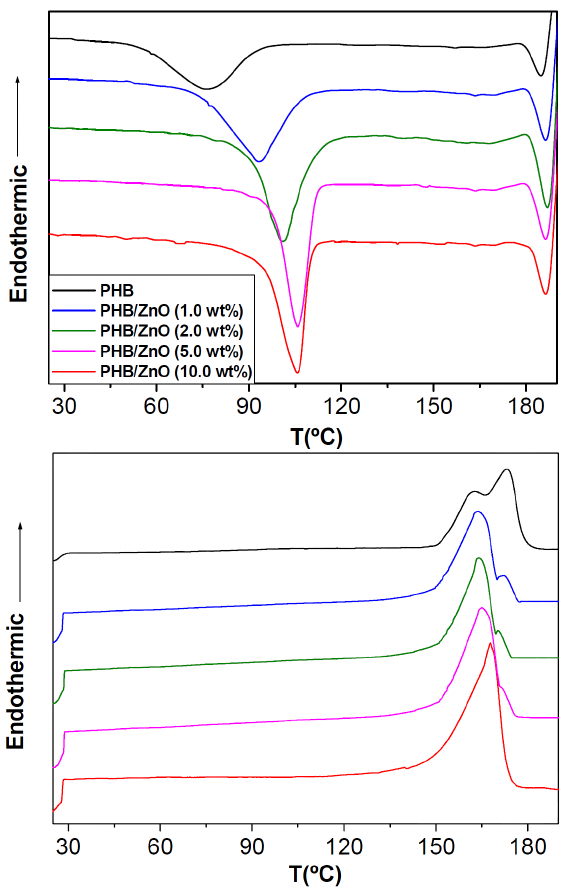
Figure 5. Non-isothermal DSC cooling ( top ) and second heating ( bottom ) scans of PHB and the nanocomposites at a rate of 10